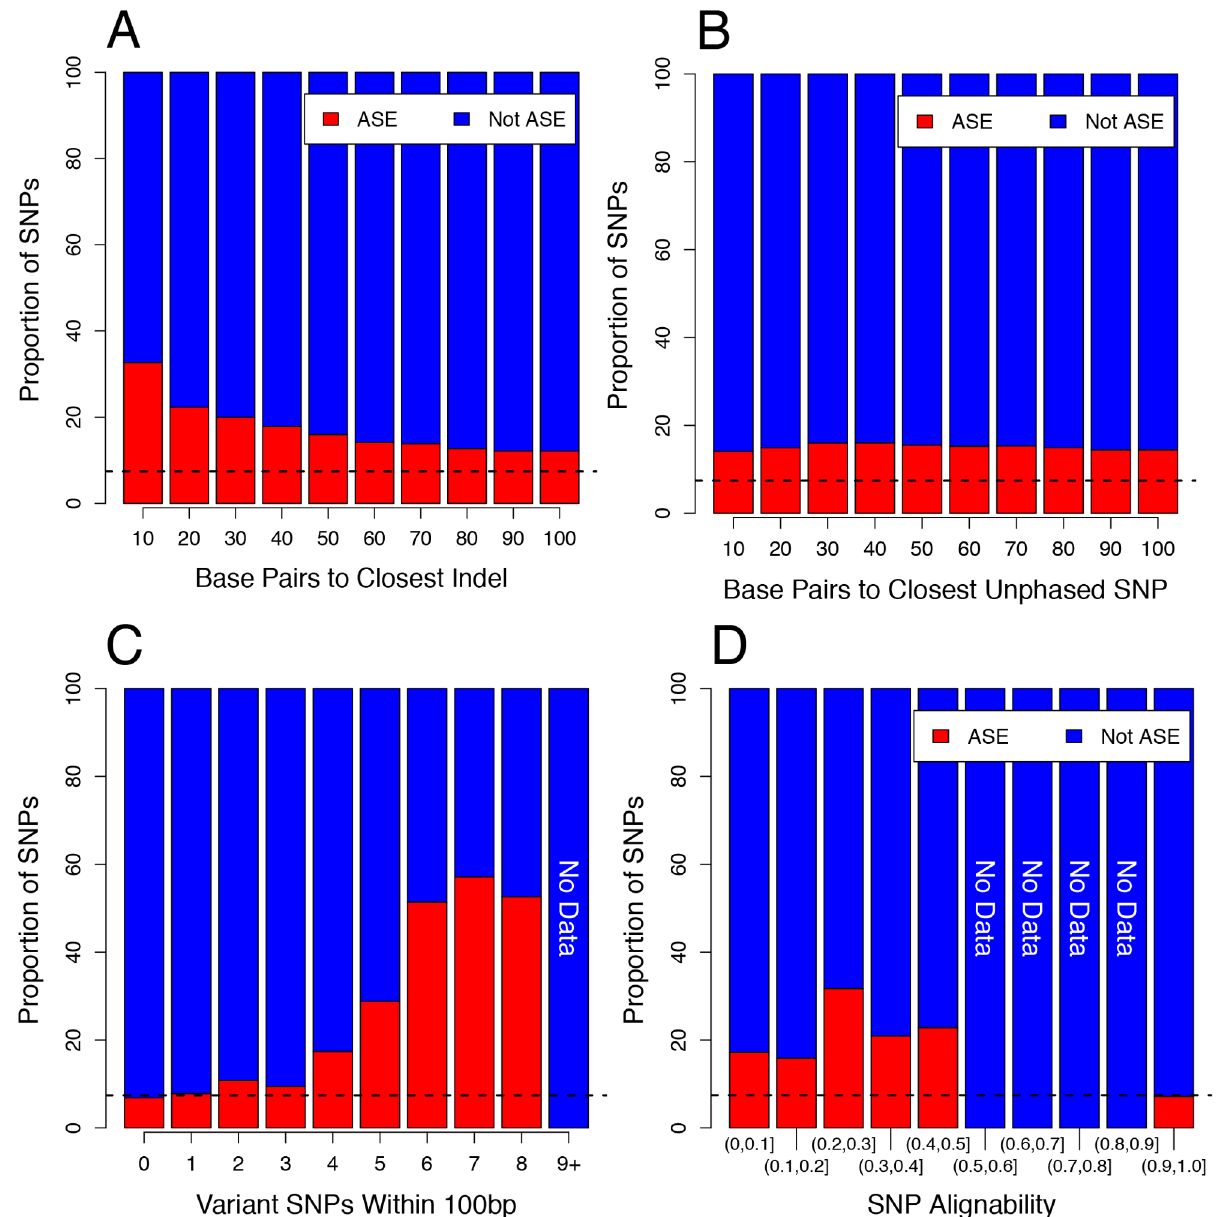
Fig 2. SNPs proximal to SNVs are more likely to be ASE. (A) SNPs binned by genomic distance to nearest heterozygous indel. (B) SNPs binned by nearest heterozygous un-phased de novo called SNP. (C) SNPs binned by the number of proximal heterozygous SNPs. (D) SNPs binned by genomic alignability. The closer a SNP is to a heterozygous SNV, the more likely that SNP is to be classified as ASE. For indels, this effect is stronger than SNPs, which are only slightly affected, however as the number of SNPs within a read length (100bp) increases, this effect is increased. In all plots, the dashed line represents the average ASE proportion for all SNPs. Numbers at the top of the bars indicate the number of SNPs in each bin (blue not ASE, red